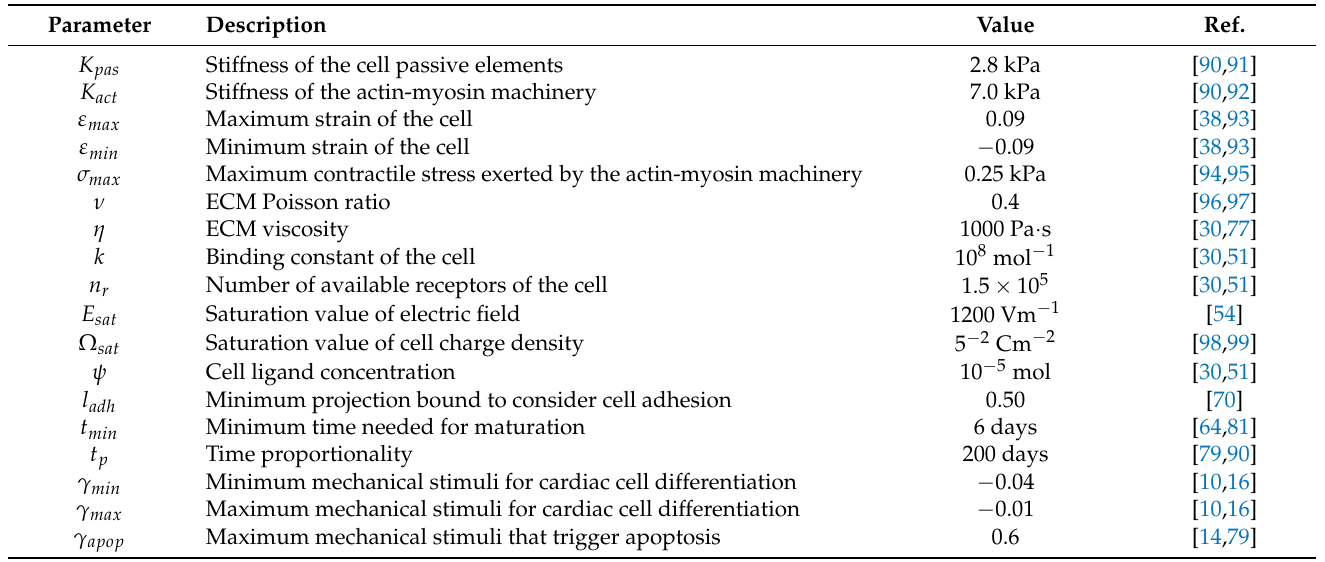
Figure 5. Algorithm of the model implemented for each time step. Table 1. Considered mechanical parameters in the